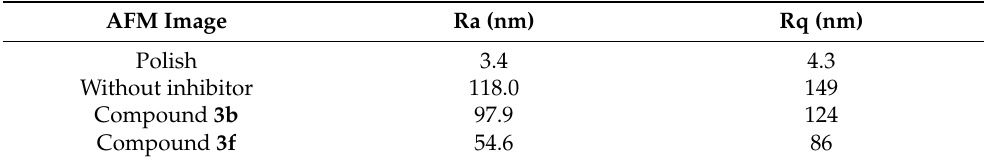
Table 5. Roughness values calculated from the AFM images shown in Figure